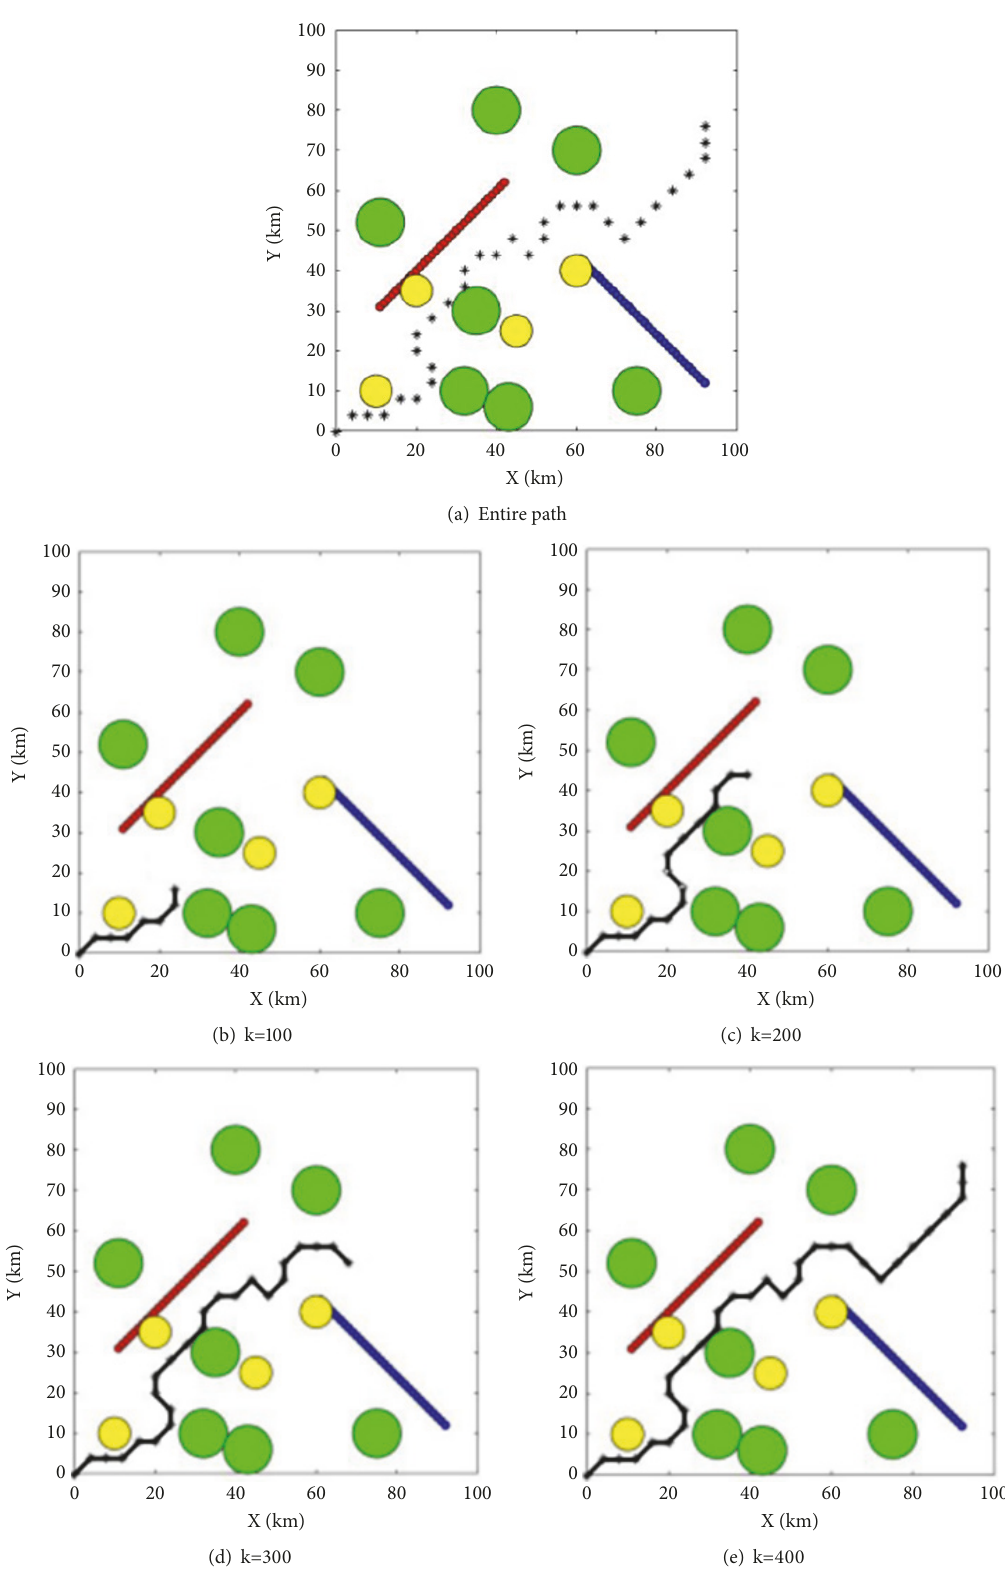
Figure 13: UAV path planning in another environment based on ACO algorithm. And there are both static and mobile threats where (a) is an entire path and (b) to (e) are paths with iterations = 100, 200, 300,